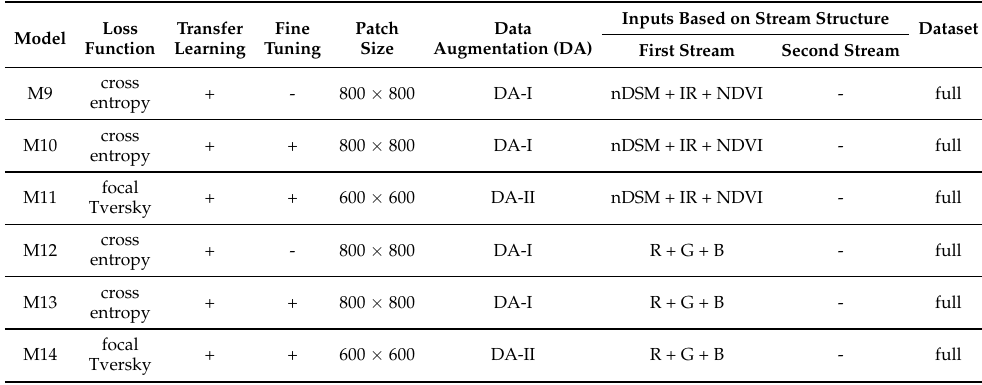
Table 5. Features of different training approaches and inputs using full dataset for single-stream segmentation